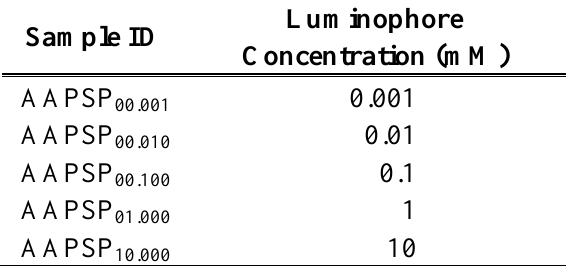
Table 1. Dipping conditions of AA-PSP. Dipping solvent was dichloromethane. Anodized- aluminum coatings were dipped at room temperature for one